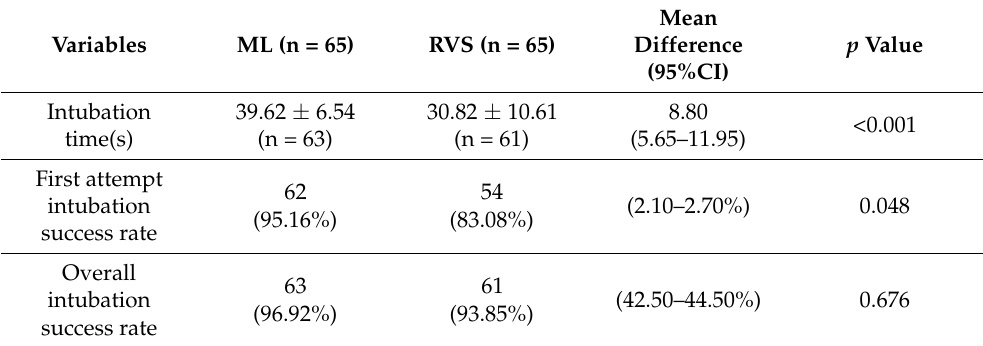
Table 2. Intubation time and success